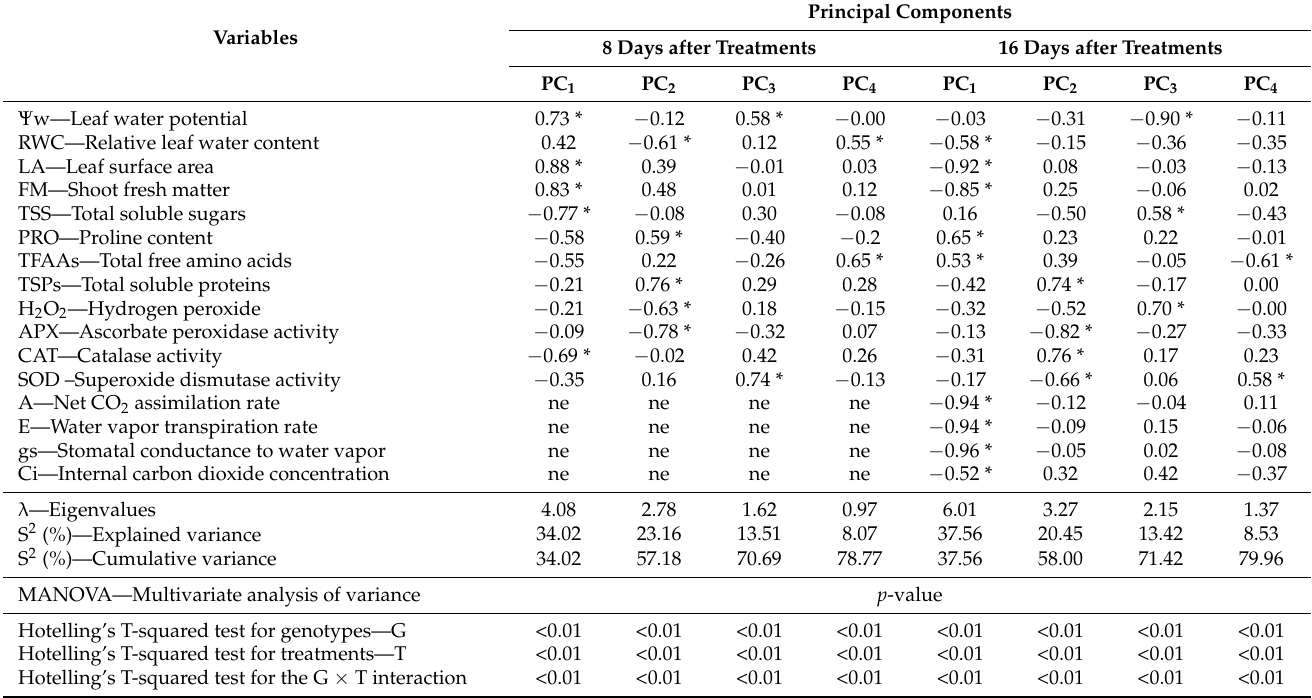
Table 1. Correlation between original variables and principal components, eigenvalues, explained and cumulative variances, and the probability of significance of the test of hypothesis after eight and 16 days of the application of